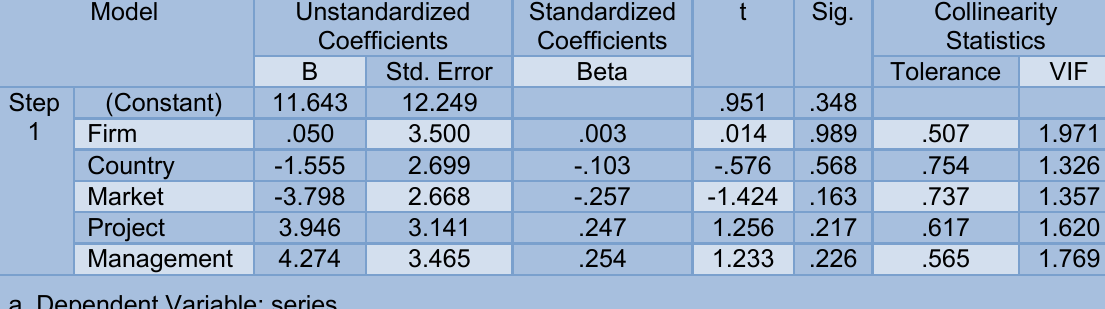
Table 6: Coefficients a and collinearity statistics for EL Decision